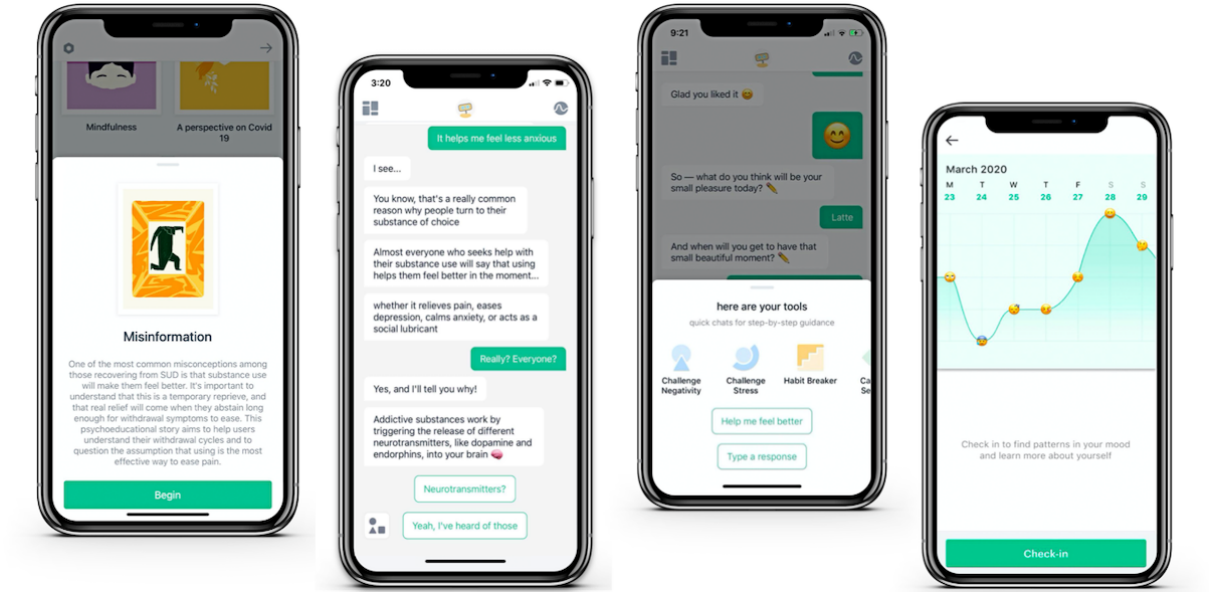
Figure 2. Sample screenshots of the Woebot for substance use disorders app: a psychoeducational lesson called Misinformation, the core conversational panel (featuring the Lesson Misinformation), and psychotherapeutic skills for behavior change and mood